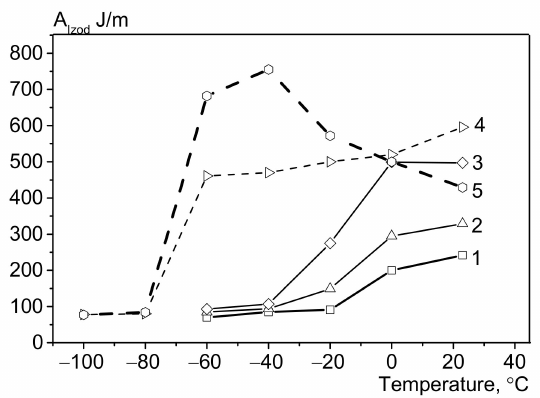
Figure 12. The Izod impact strength of HDPE, LLDPE, and their blends at different test temperatures: HDPE (1), HDPE/LLDPE = 70/30 (2), 50/50 (3), 20/80 (4), and LLDPE (5).